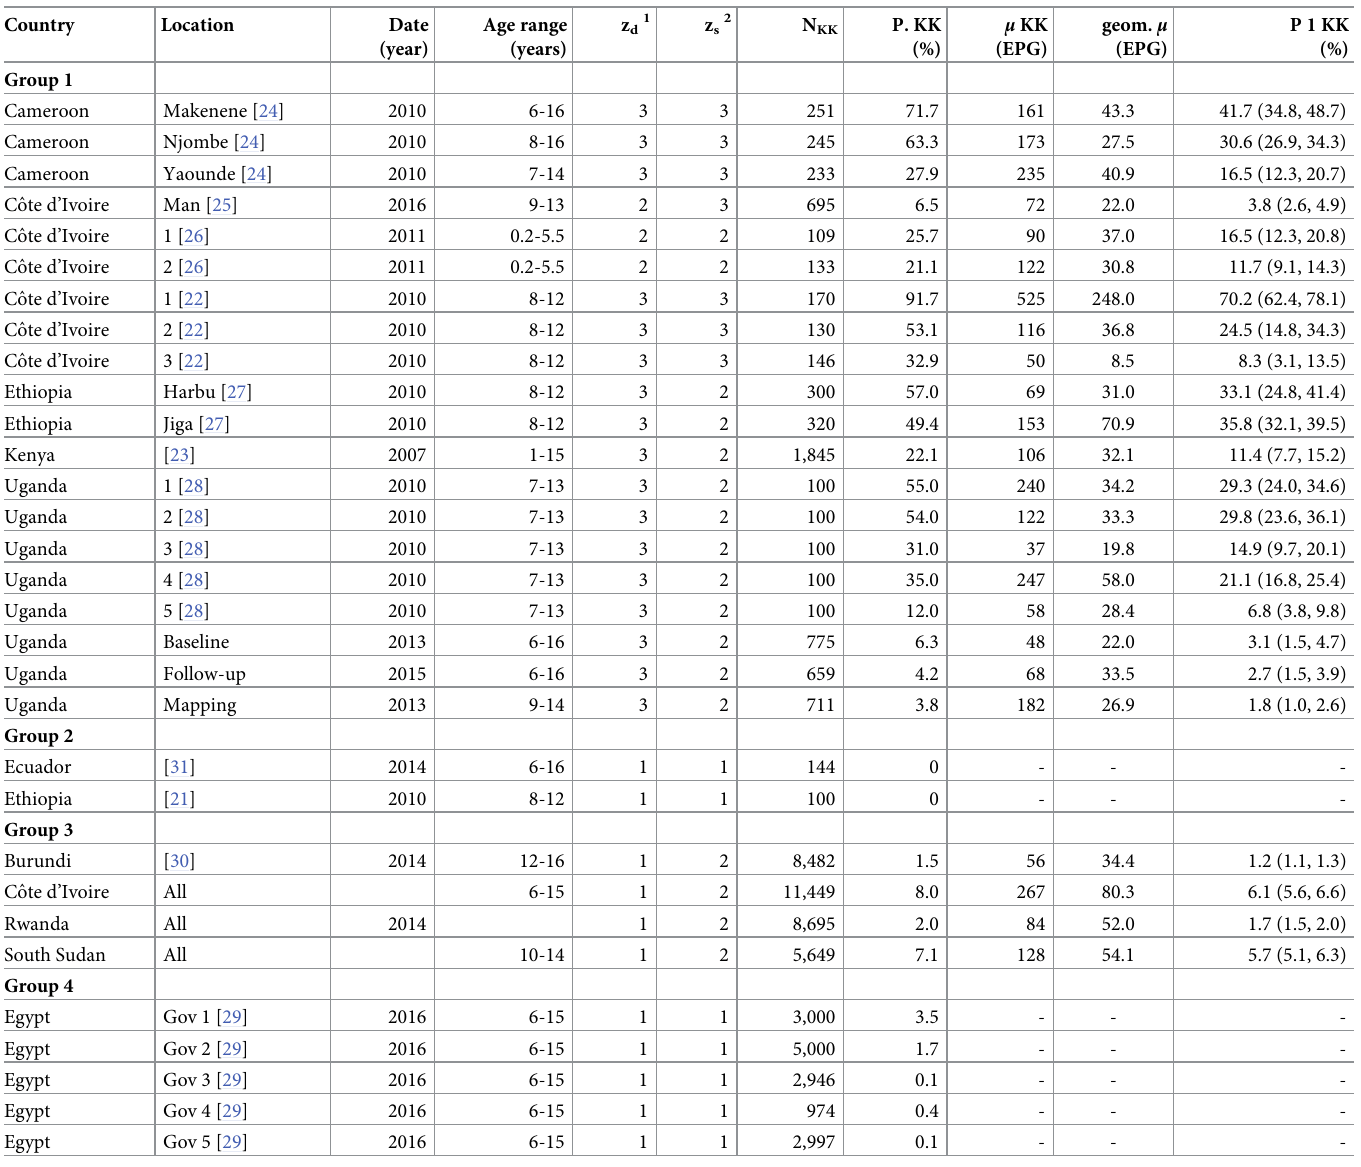
Table 1. Summary of the Kato-Katz results of the databases.